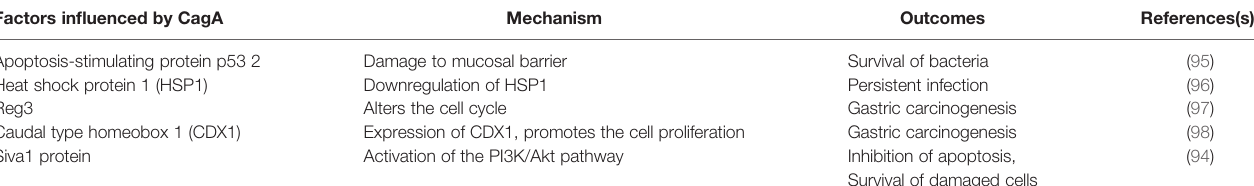
TABLE 1.2 | Mechanisms of CagA-mediated gastric carcinogenesis. Factors in fl uenced by